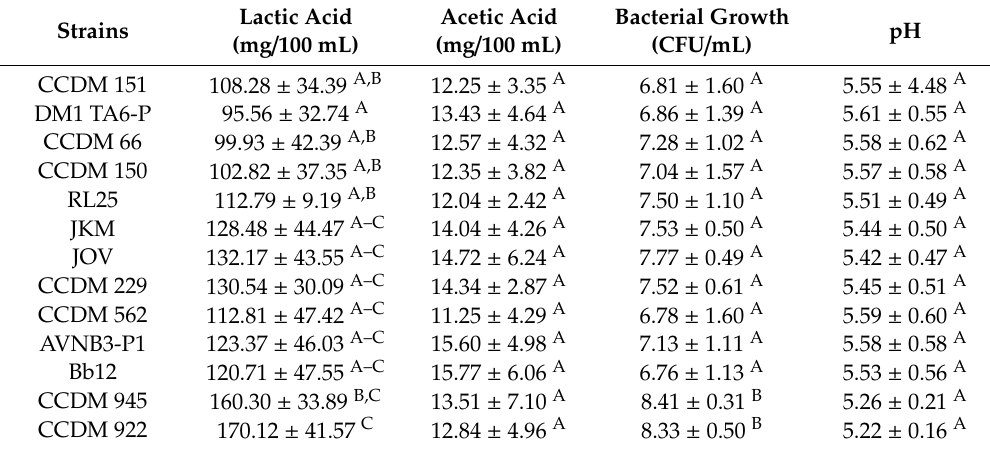
Table 5. Comparison of average values of tested parameters after 24 h of cultivation selected strains in bovine